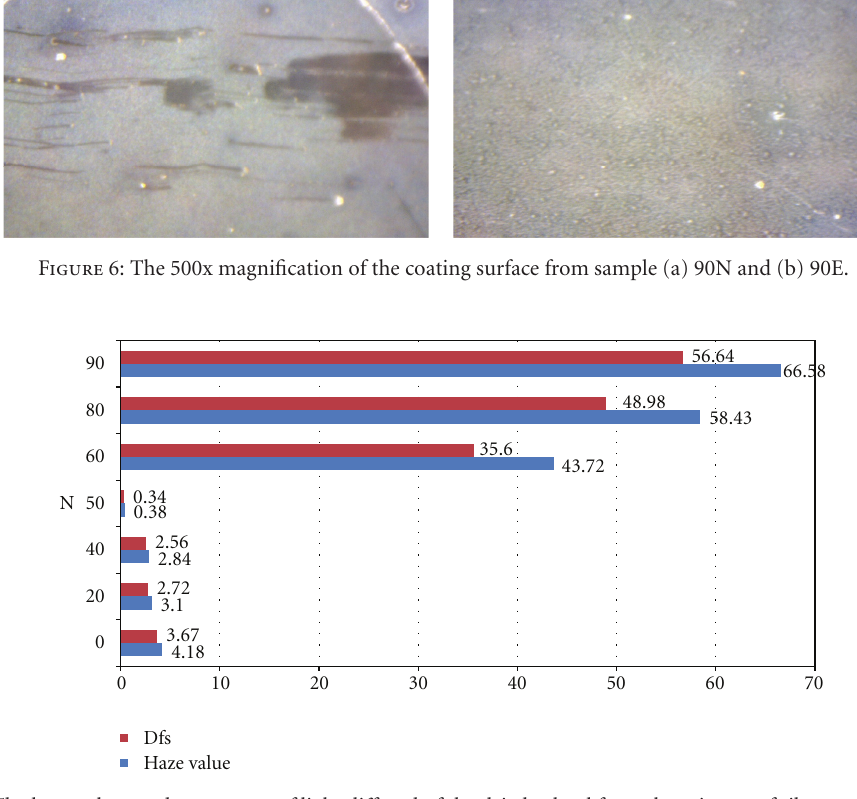
Figure 7: The haze values and percentage of light di ff used of the dried sol-gel from the mixture of silane and